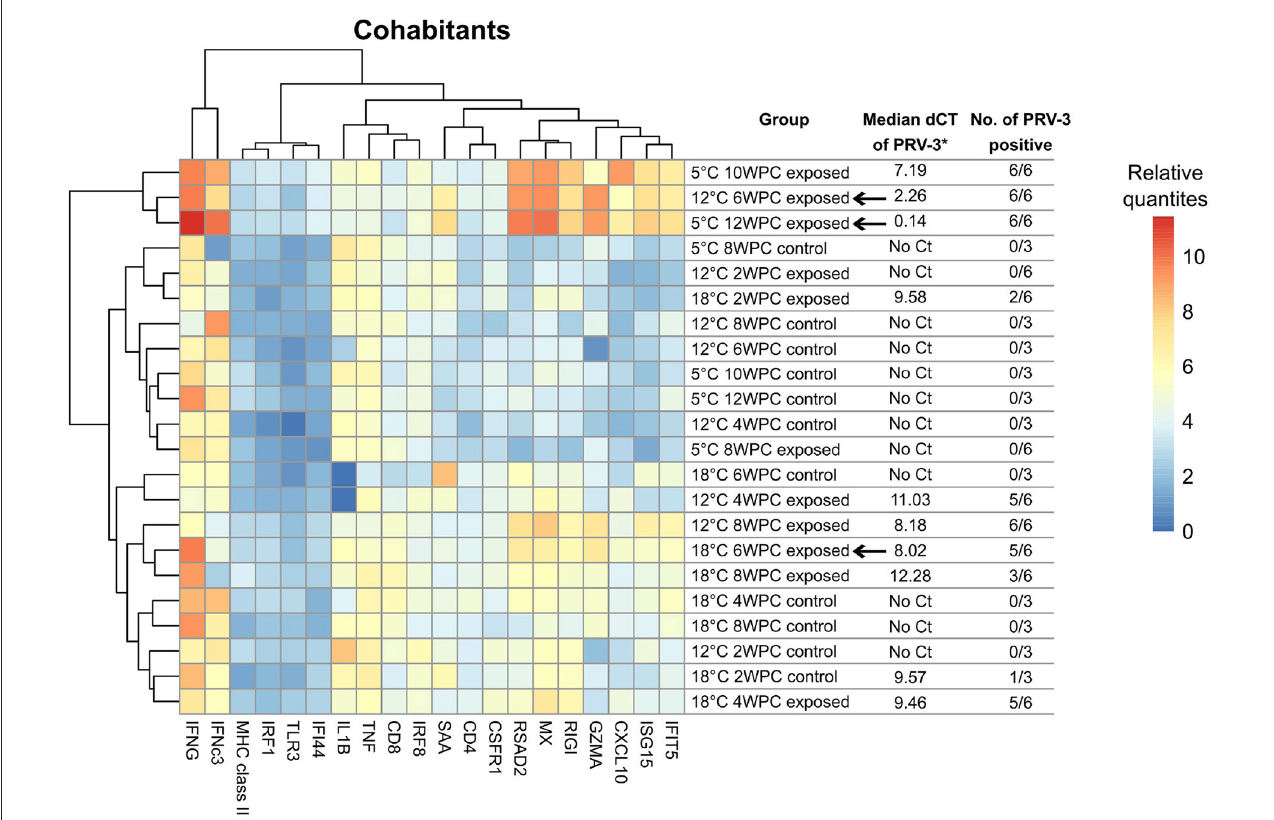
FIGURE5 Heatmap of median log2 transformed relative quantities of immune gene expression analyses of selected cohabitant groups. Arrows indicate time point for peak in virus load. ∗ Low value corresponds to high virus load (dCt = Ct[PRV-3] − Ct[Reference gene]). SD values of each group are shown in Supplementary